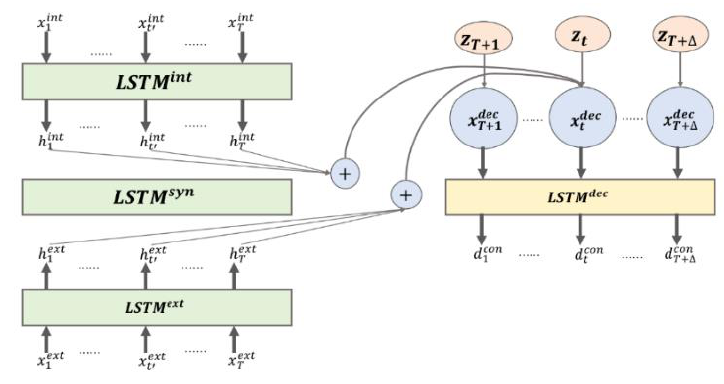
Figure 6. Improved decoder stage.